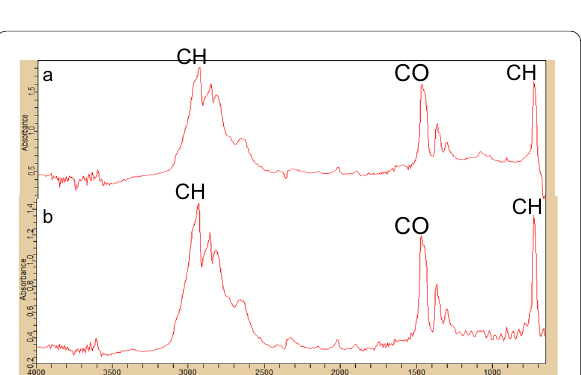
Fig. 6 Infrared peaks of polyethylene sample cultured with Aspergillus nidulans ( a ) and control sample ( b